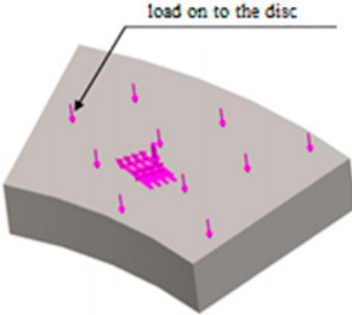
Figure 16. Acting load on the mirror surface of the disc.